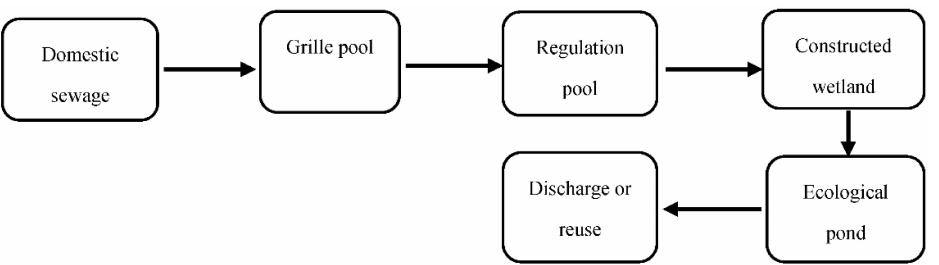
Figure 1. Location of the study area.